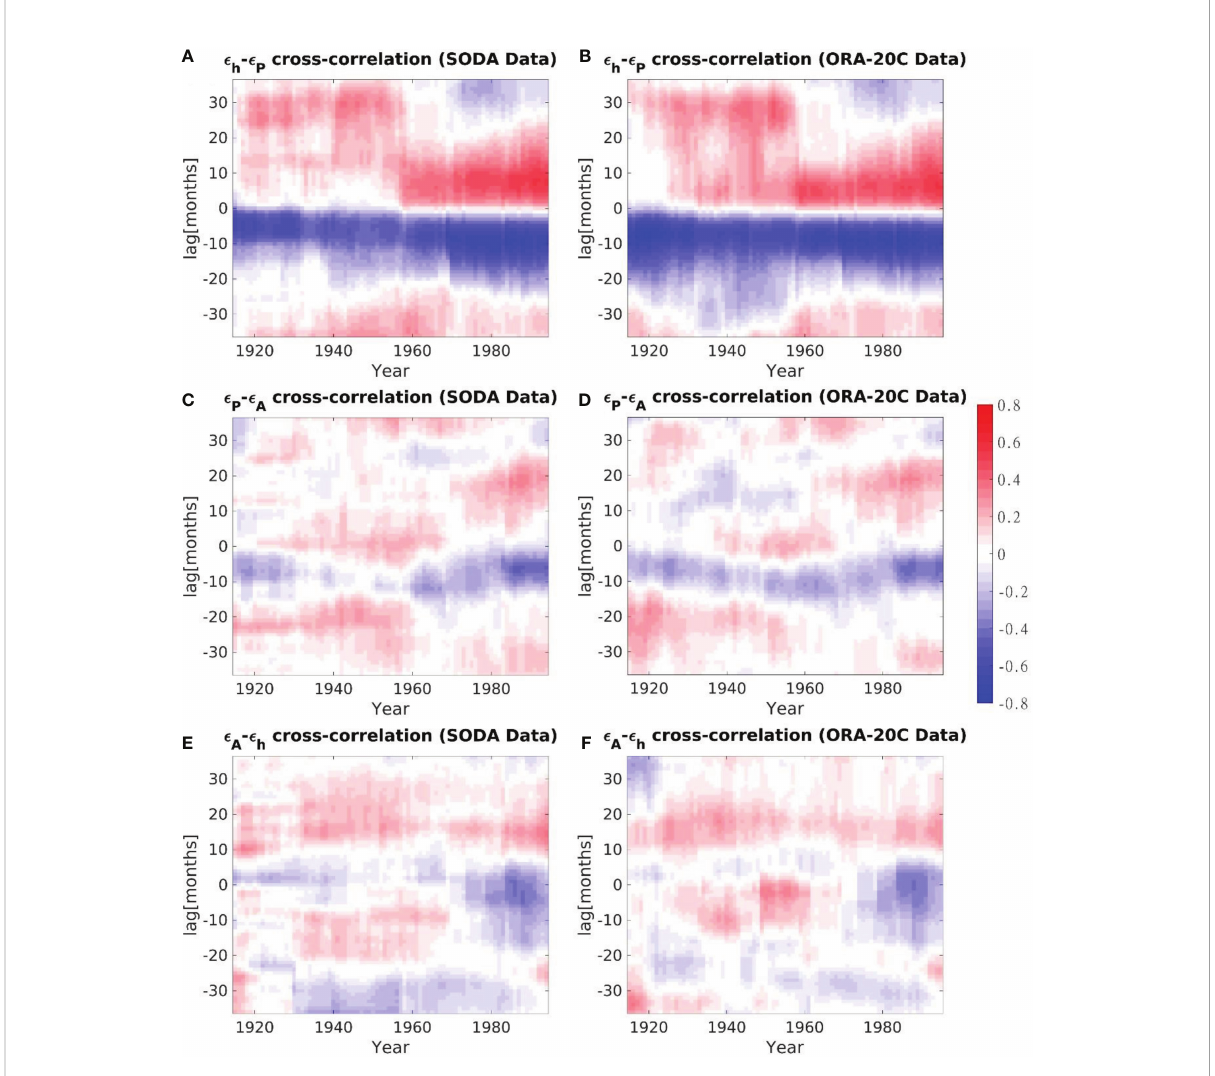
FIGURE 8 Color map of the normalized cross-correlation function c N hP ( e h leads for positive lags), c N PA ( e P leads for positive lags), and c N Ah ( e A leads for positive lags), both for SODA (period 1900-2008, A , C , E , respectively) and ORA-20C (period 1900-2009, B , D , F , respectively) reanalysis. Each column represents the function for a time window of 30 years, and the represented year in the horizontal axis is the mean value of that interval. The vertical axis indicates the lag in the cross-correlation function. Red Blue Colormap (Auton, 2022) was used in this fi